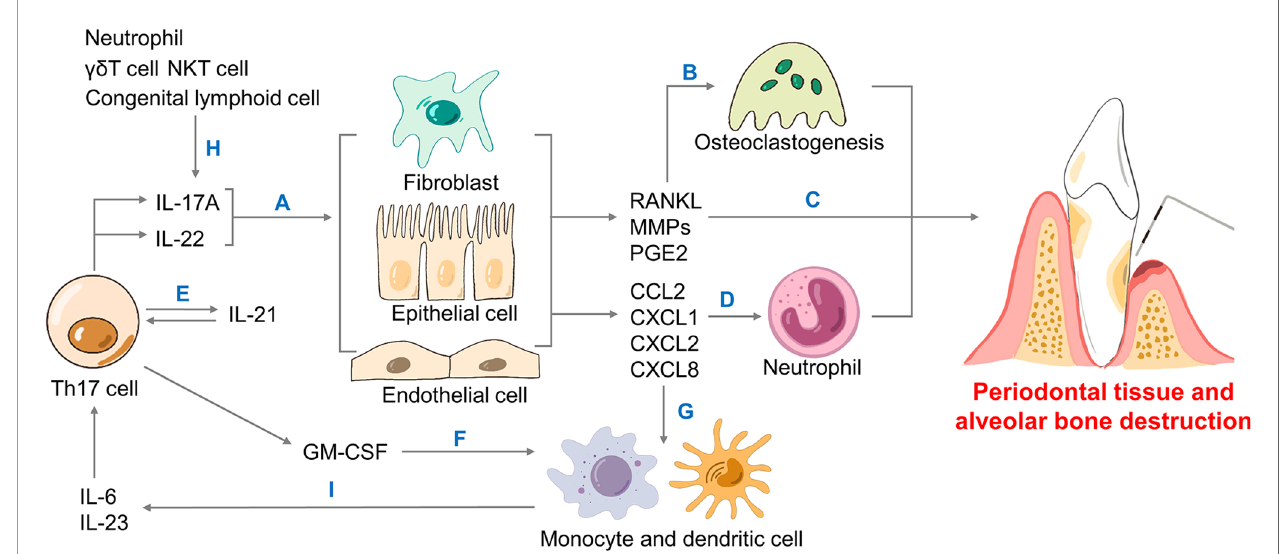
FIGURE 2 | The role of Th17 cells in periodontitis. Th17 cells secrete cytokines including IL-17A, IL-22, IL-21 and GM-CSF. (A) IL-17A and IL-22 bind to non- hematopoietic cells like fi broblasts, epithelial and endothelial cells to generate RANKL, MMPs, PGE2, as well as chemokines. (B) RANKL leads to osteoclastogenesis, the driving force of bone resorption. (C) MMPs, PGE2 together with neutrophils contribute to periodontal in fl ammation and alveolar bone loss. (D) IL-17A mediates neutrophil recruitment in periodontitis via generating chemokines including CXCL1, CXCL2 and CXCL8. (E) Produced by Th17, IL-21 forms a positive loop that directly promotes Th17 recruitment. (F) Th17 cells produce GM-CSF that promotes monocyte and dendritic cells. (H) Neutrophils and innate type 17 cells like gd T cells, NKT cells and congenital lymphoid cells could induce IL-17A as well. (G) Chemokines contribute to monocyte and dendritic cells. (I) Monocytes and dendritic cells generate IL-6 and IL-23 that help Th17 cells differentiate. Th, T helper; IL-, interleukin-; GM-CSF, granulocyte-macrophage colony-stimulating factor; RANK, receptor activator for nuclear factor- k B; RANKL, RANK ligand; MMPs, metalloproteinases; PGE2, prostaglandin E2; CXCL, CXC motif ligand; NKT, natural killer